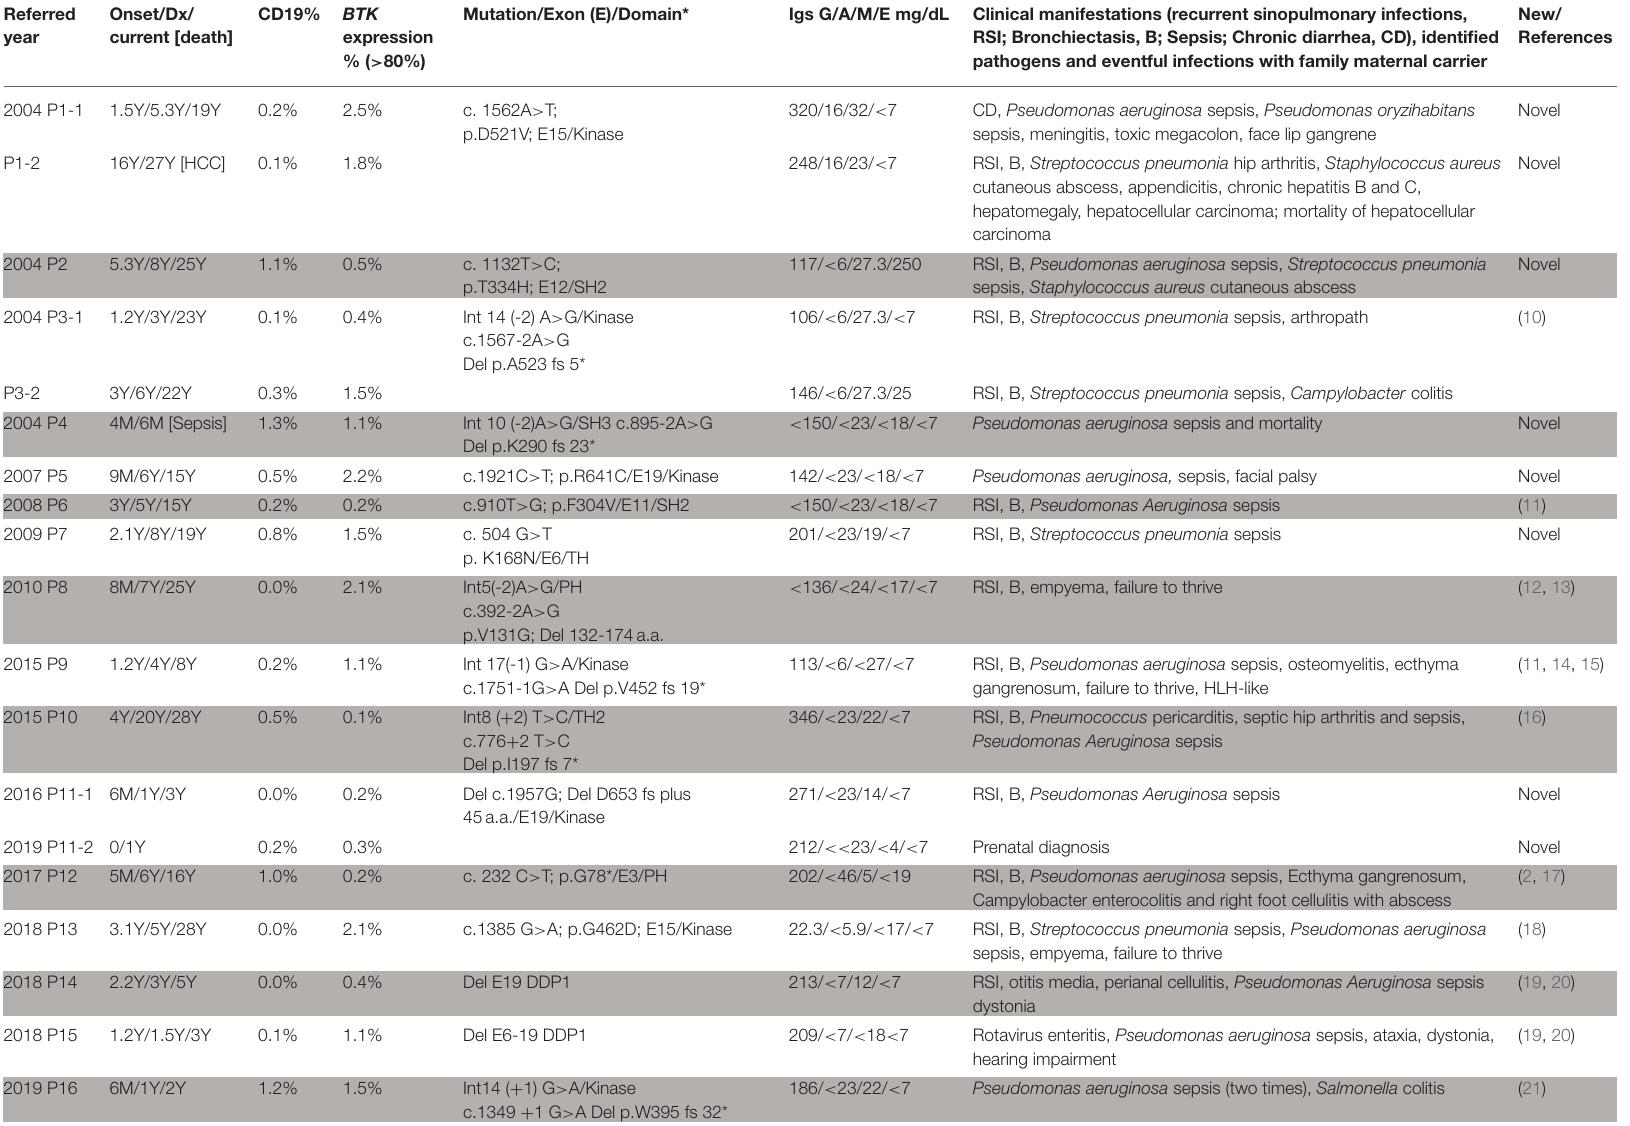
TABLE 1 | Clinical features of the XLA patients with BTK genetic mutations by the referred